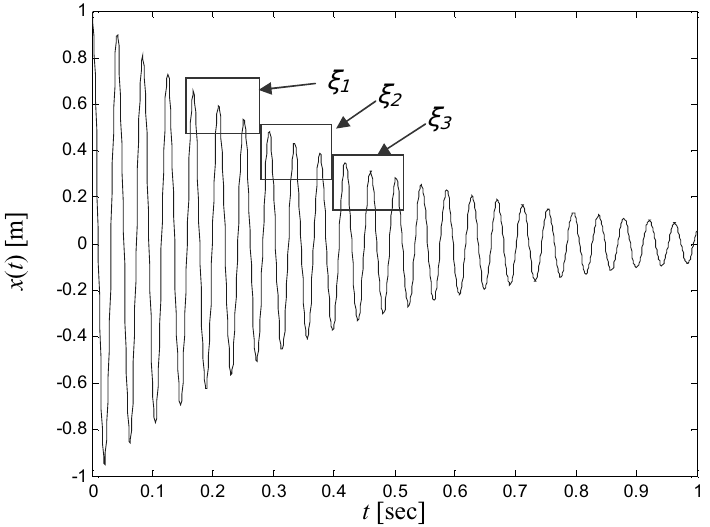
Fig. 6. Application of log decrement method to nonlinear damping.